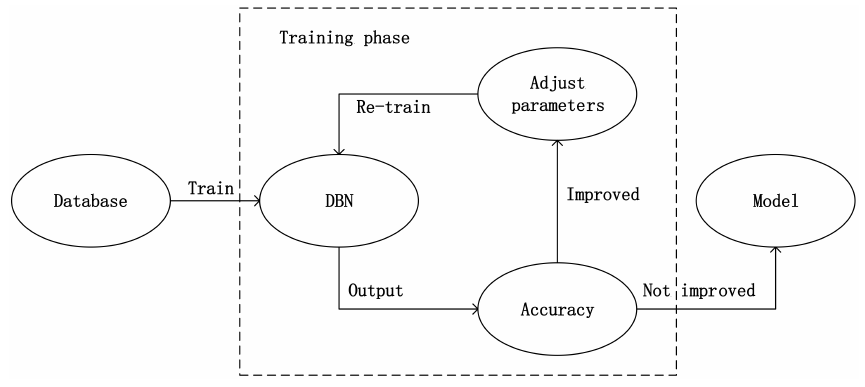
Figure 6. DBN training phase.